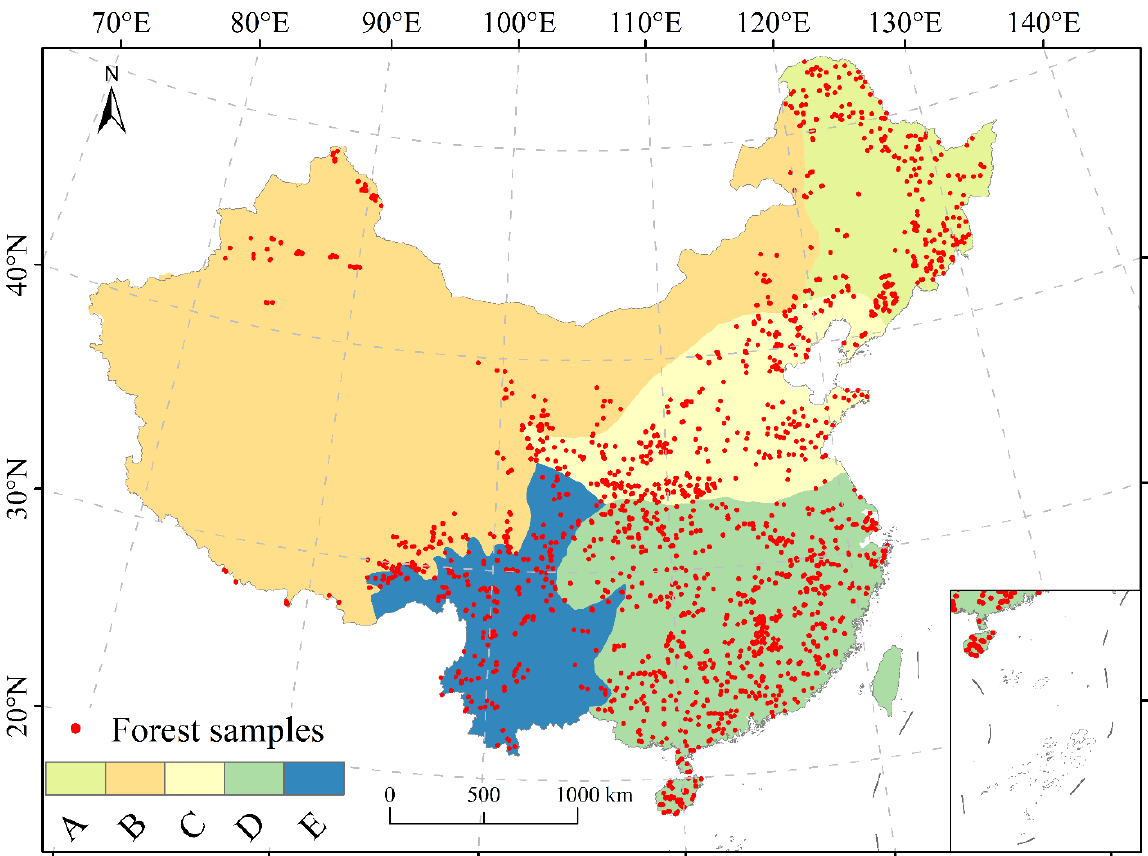
Figure 1. Location of the field sites as indicated by the solid red circles and the five forest regions in China.